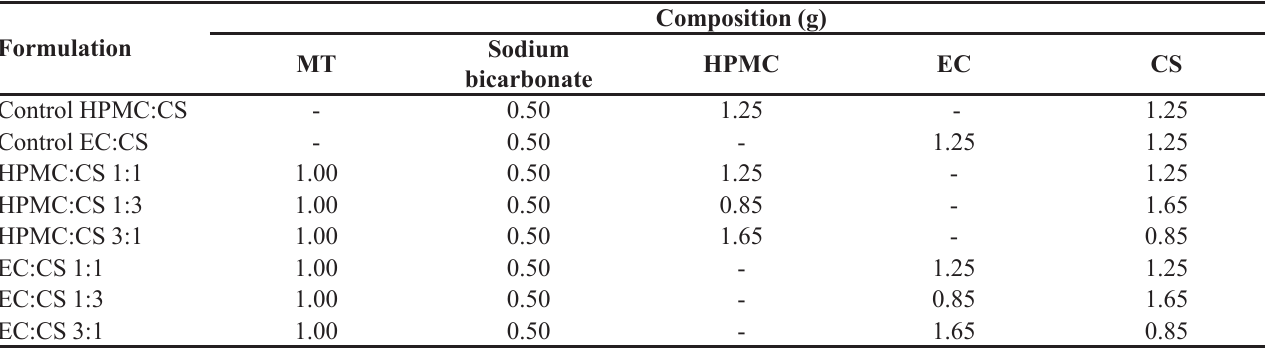
TABLE I - Floating systems composition